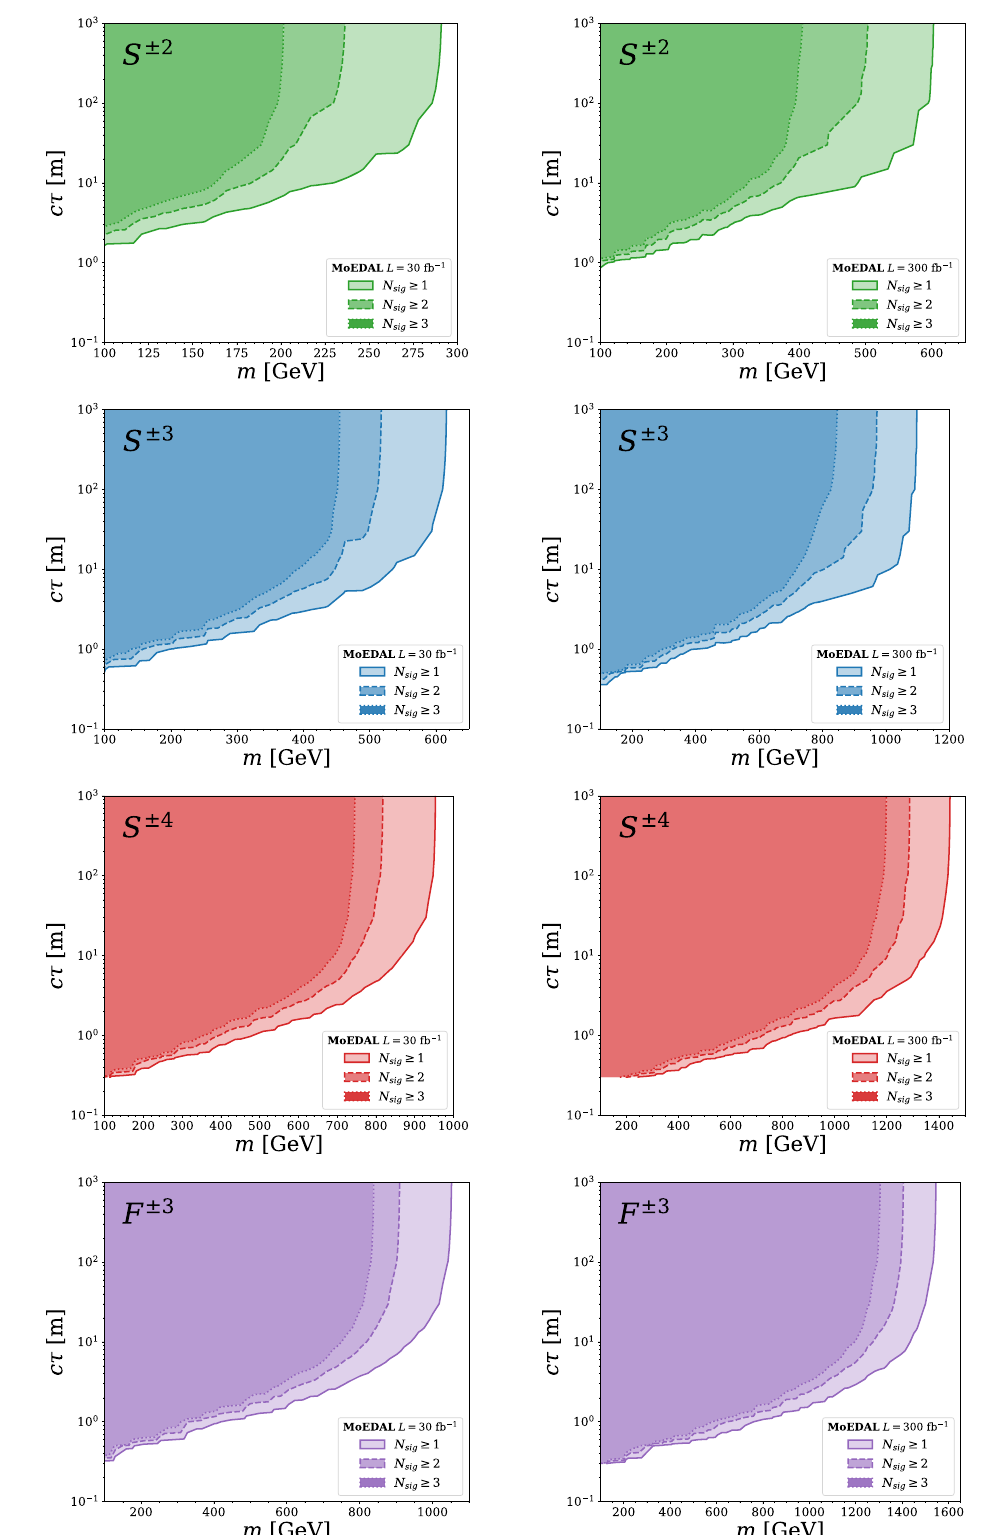
Fig. 5 Model-independent detection reach at MoEDAL in the ( m , c τ ) parameter plane for individual particles of Model-1. The solid dashed and dotted contours correspond to N sig = 1, 2 and 3, respectively. In the left (right) panel the integrated luminosity of 30 (300) fb − 1 is